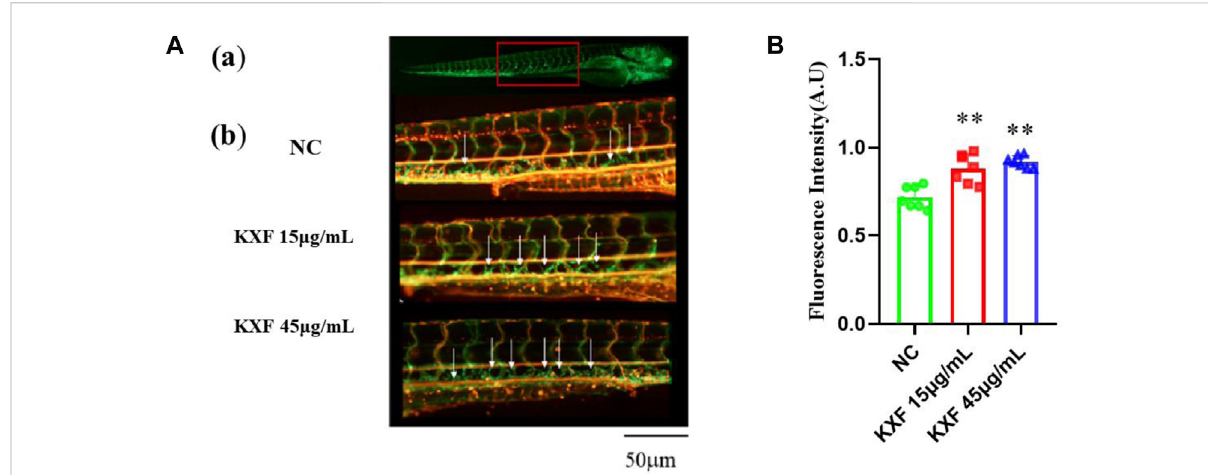
FIGURE 6 KXF increased the lymphatic thoracic duct formation in zebra fi sh. (A) . Confocal image of the 96 hpf. zebra fi sh vascular system. (A) . The red- boxedregionindicatestheareaoftheconfocalimage(fromtheseventhoreighthtothe18thsomite). (B) .Representativeconfocalimagesshowthat KXF promoted the thoracic lymphatic duct formation in zebra fi sh, the white arrow indicates the thoracic lymphatic duct; (B) . Quantitation of the fl uorescence intensity of the thoracic lymphatic duct. ** p < 0.01 vs. NC